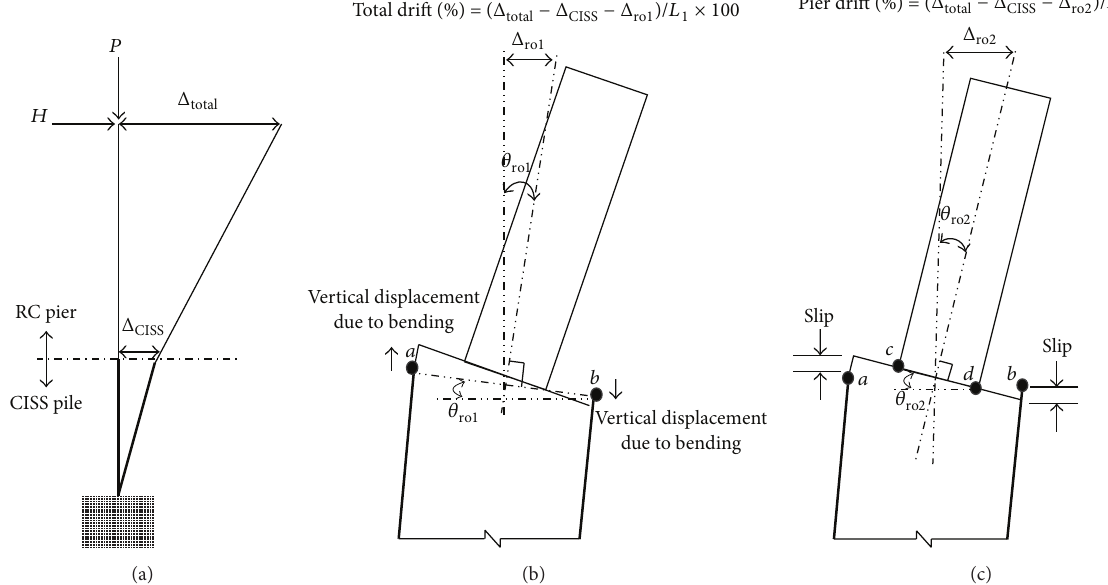
Figure 10: Definition of total and pier drift: (a) deflection of CISS pile and RC pier; (b) definition of total drift; and (c) definition of pier drift.